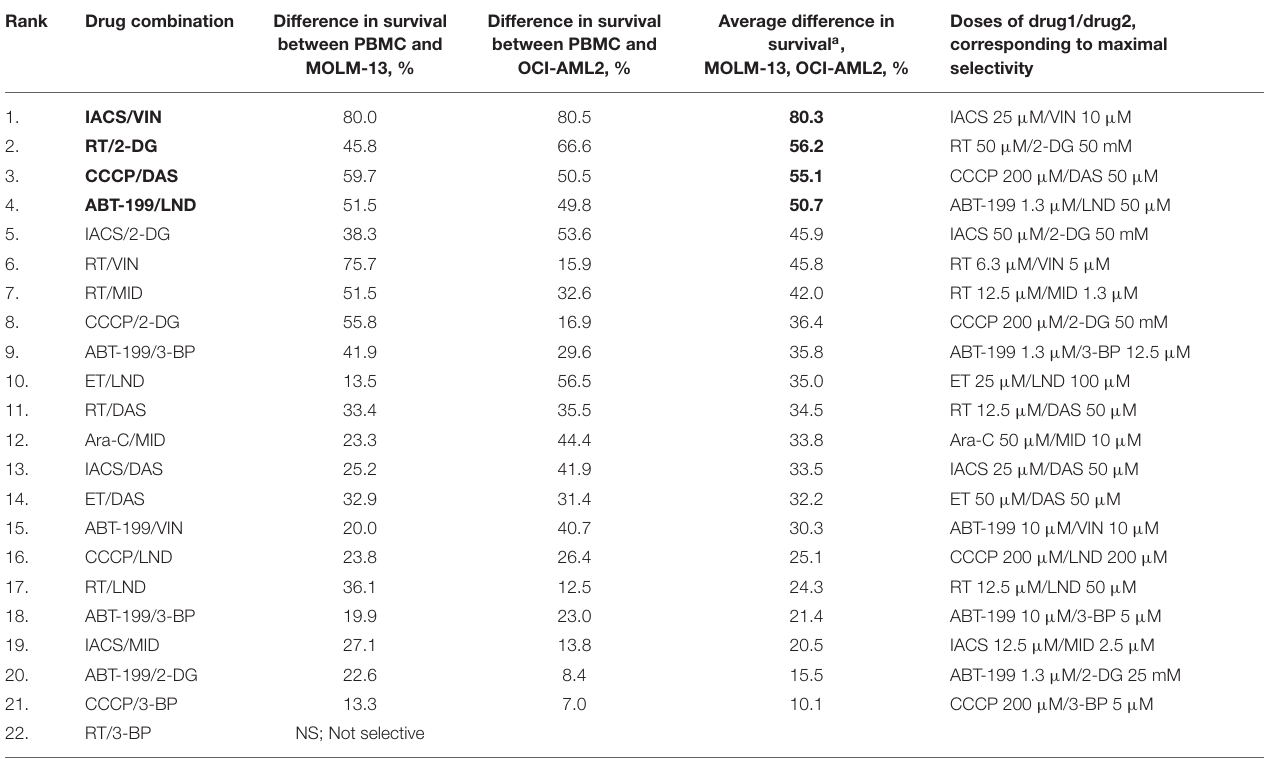
TABLE 2 | Effective mitocan-based drug combinations ranked in order of decreasing selectivity. Rank Drug